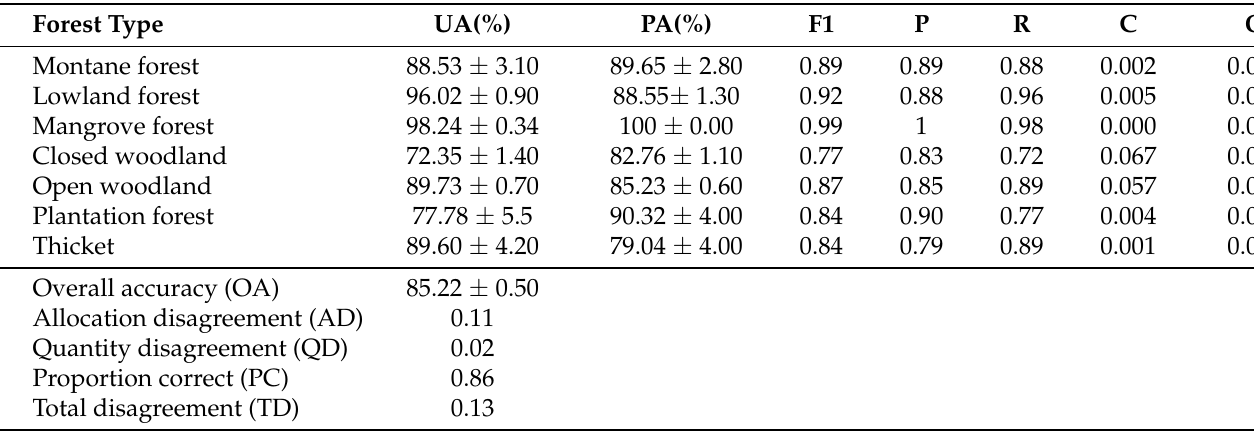
Table 7. Thematic accuracy measures of the forest types